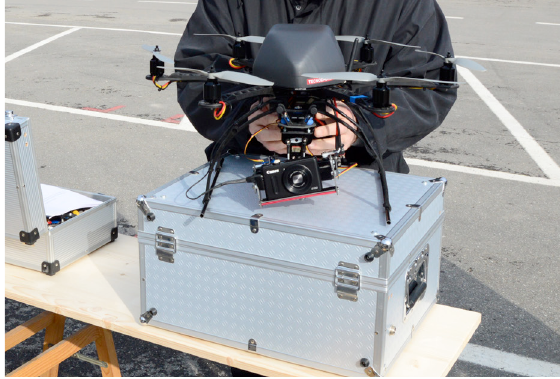
Figure 7: The UAV used for the acquisition The camera mounted on the vehicle was a Canon Powershot S100, a compact camera light enough to be lifted by our hexacopter (198 g), but with a good resolution and characteristics suitable for the job (tab 8).